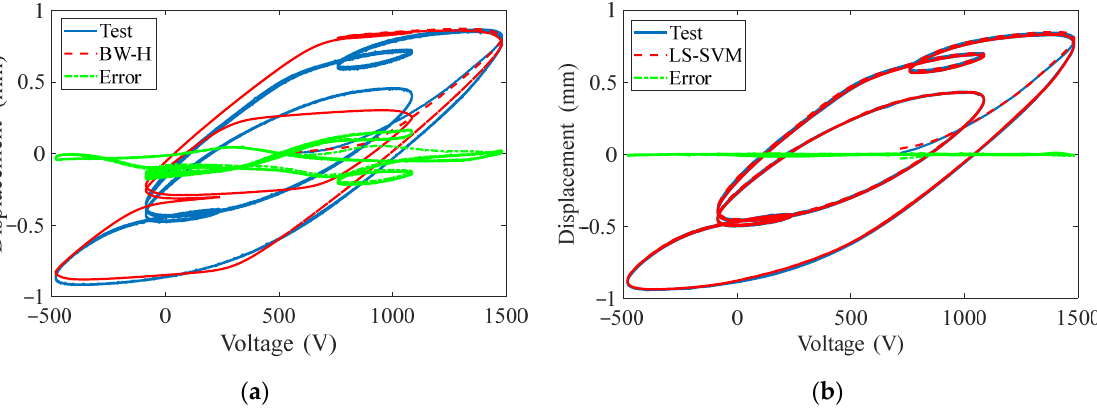
Figure 10. Predicated displacements comparison of two models under the excitation voltage of multiple frequencies superposition: ( a ) BW-H model, ( b ) LS-SVM model. The REs of the BW-H model and the LS-SVM model are 20.9% and 0.76%, respec-